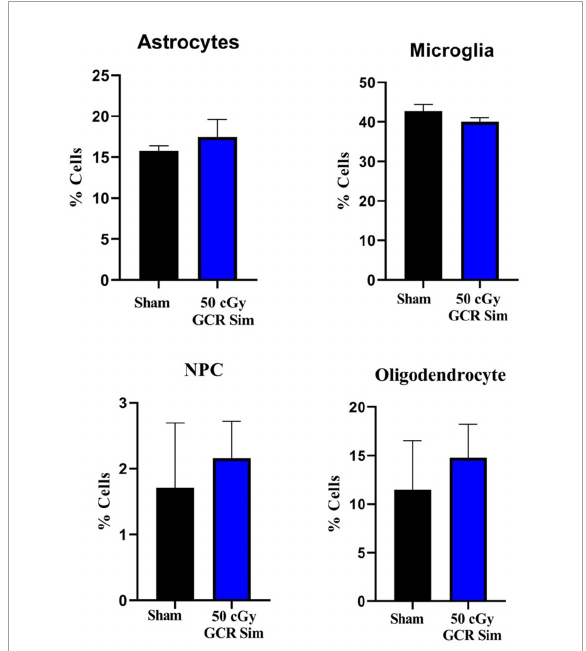
FIGURE3 Flow cytometry was used to measure changes in astrocytes (ACSA-2–positive), neural precursor cells (PSA-NCAM–positive), microglia (CD11b-positive), and oligodendrocytes (O4-positive) of hippocampal tissue in sham-irradiated ( n = 6) and irradiated ( n = 6) (50 cGy GCR) mice. There were no significant changes in the proportions of each cell type between either treatment group. NPC, neural precursor cells.